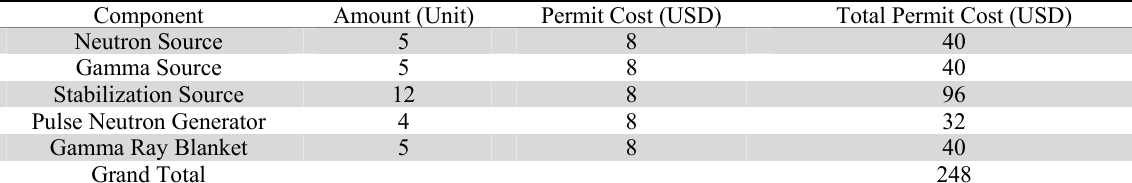
Annually Usage Permit Cost Based on Monthly Movement Component